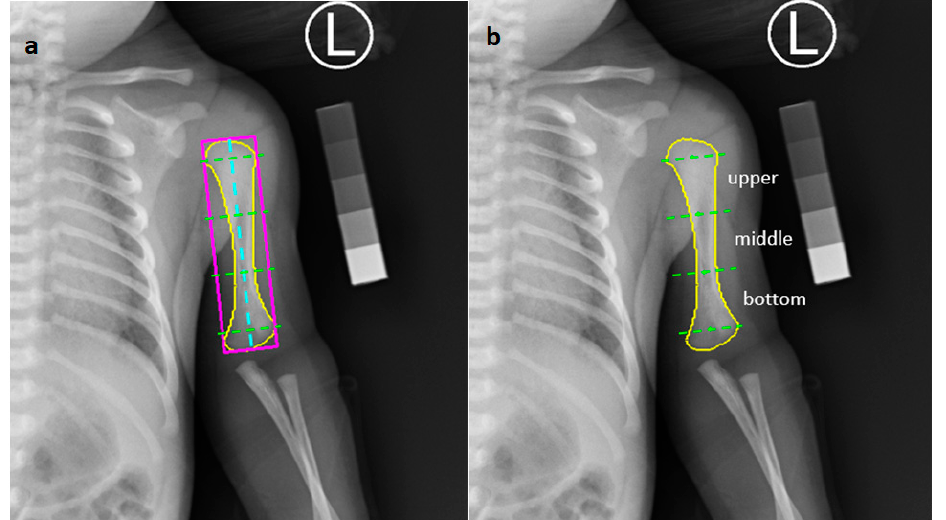
Figure 5. ( a ) The yellow contour is a segmented area, the pink rectangle is the minimum-bounding rectangle of the segmented area, and the blue dashed line is the central axis of the humerus. ( b ) Three separate areas of the bone are determined for further BMD estimation.